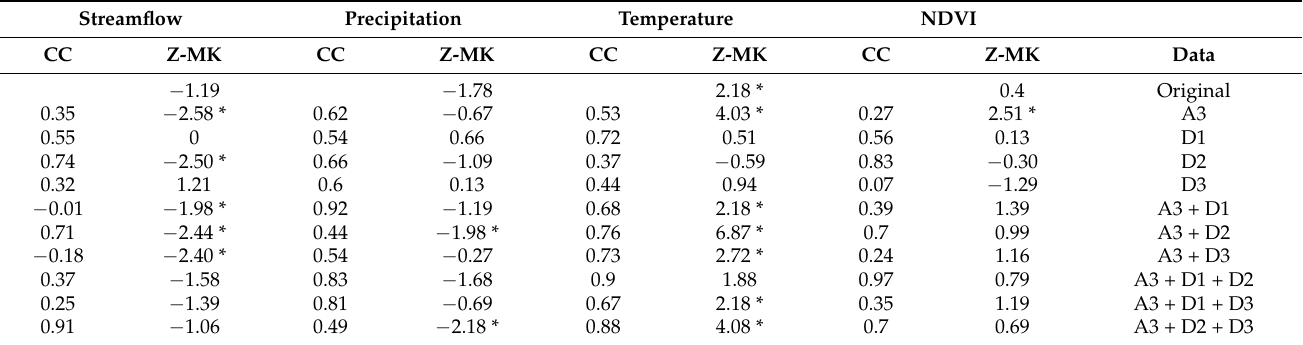
Table 4. Mann–Kendall Z-values and correlation coefficients of annual time